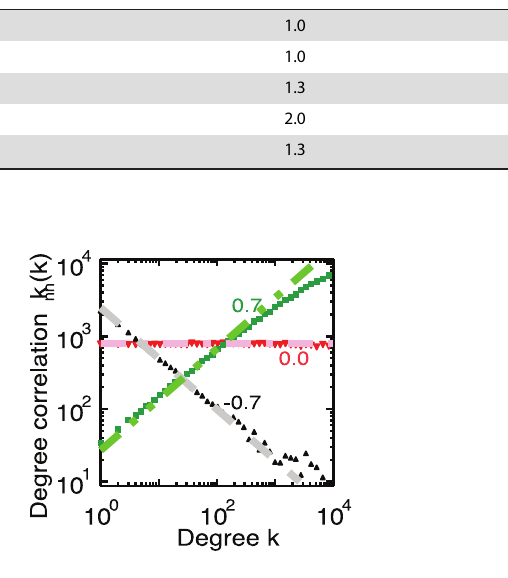
Figure 2. The averages degree of nearest neighbours as a function of degree of the artificial networks, k nn ( k ) . The black triangles indicate the network for c ~{ 0 : 7 , the red nablas for c ~ 0 : 0 and the green squares for c ~ 0 : 7 . The black dashed line is proportional to k { 0 : 7 , the red dash-dotted line is proportional to k 0 : 0 and the green dash-double-dotted line is proportional to k 0 : 7 .